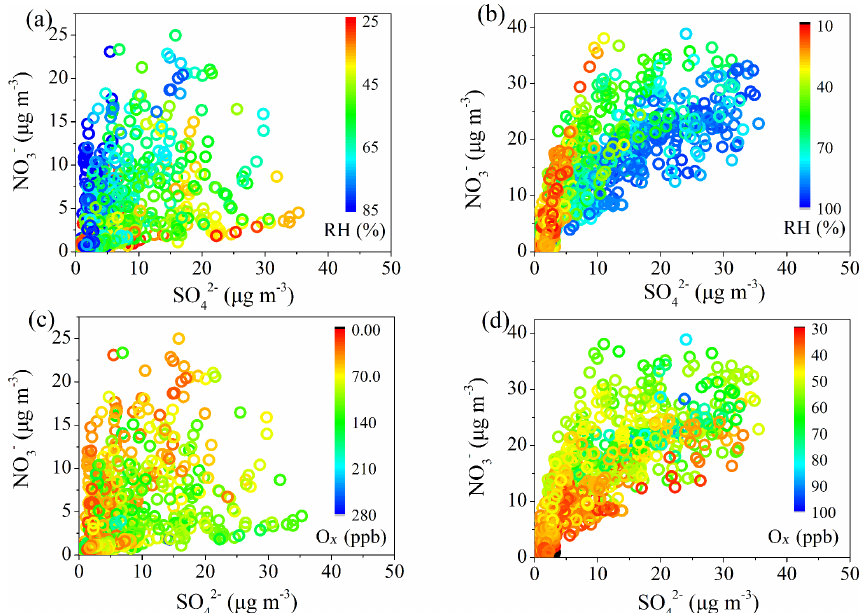
Figure 4. Correlations between NO − SO 2 − , color coded with O x concentration in summer (c) and winter (d) 4